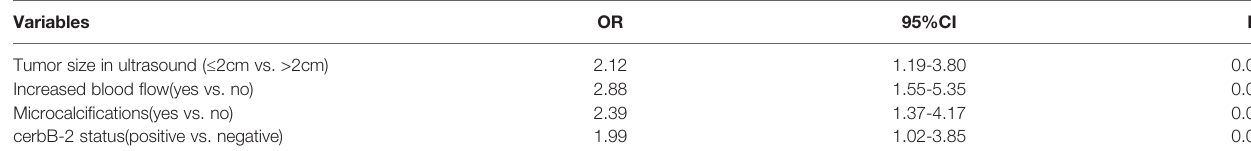
TABLE 3 | Multivariate logistic regression model for positive resection margins in the modeling cohort.